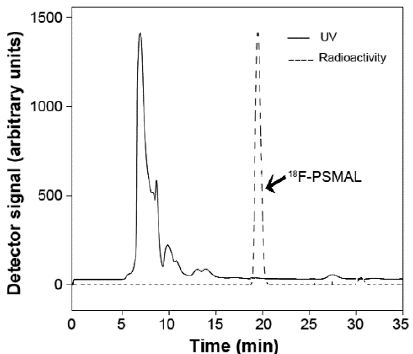
Figure 3. A representative radio-chromatogram of 18 F-labeled PSMA ligand ( 18 F-PSMAL; compound 6 ) is shown. The UV absorption was measured at 250 nm.